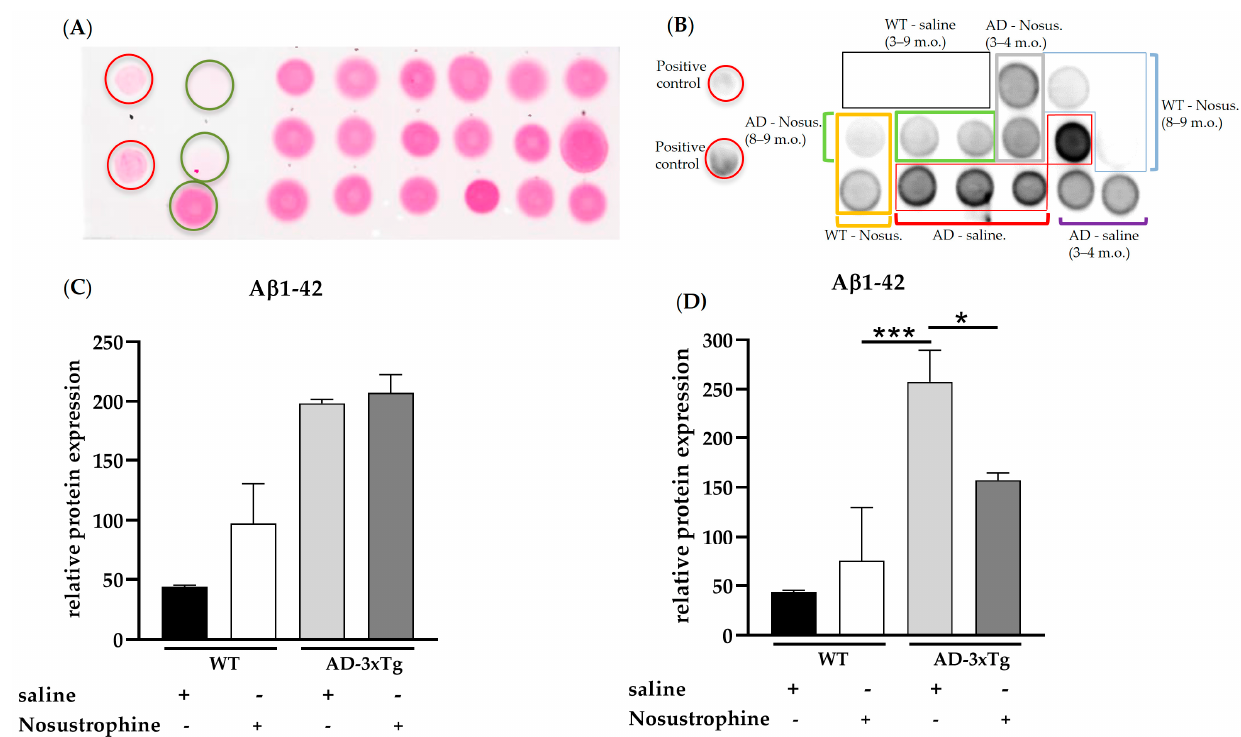
Figure 3. A β 1-42 levels in young (3–4-month-old) and older (8–9-month-old) wild-type- and AD transgenic mice. Hippocampal protein (1 μ g/ μ L) from wild-type saline-treated young ( n = 3, black box in ( B )) and older mice ( n = 3, black box in ( B )), wild-type Nosustrophine-treated young ( n = 2, orange box in ( B )) and older mice ( n = 3, blue box in ( B )), APP/BIN1/COPS5 3xTg saline-treated young ( n = 2, purple square bracket in ( B )) and older mice ( n = 4, red boxes in ( B )), and APP/BIN1/COPS5 3xTg Nosustrophine-treated young ( n = 2, grey box in ( B )) and older mice ( n = 2, green box in ( B )), A β -peptide (1-42) (0.5- and 1 µ g/ µ L) and BSA (0.01–1 µ g/ µ L) were spotted on a nitrocellulose membrane and stained with Ponceau S ( A ). The membrane was then incubated with an antibody (clone 12F4) against mouse A β 1-42 ( B ). ( C ) Quantification of A β 1-42 levels in young (3–4-month-old) and ( D ) older (8–9-month-old) mice. Data represent mean ± S.E.M. One-way ANOVA followed by Tukey’s post hoc comparisons, * p < 0.05, *** p < 0.001. AD-3xTg, triple-transgenic mouse model of AD; A β , amyloid-beta; AD, Alzheimer’s disease; BSA, bovine serum albumin; m.o., month-old; No-us., Nosustrophine; WT, wild-type. Red circles in A, positive controls (A β -peptide 1-42); green circles in A, negative controls (BSA).